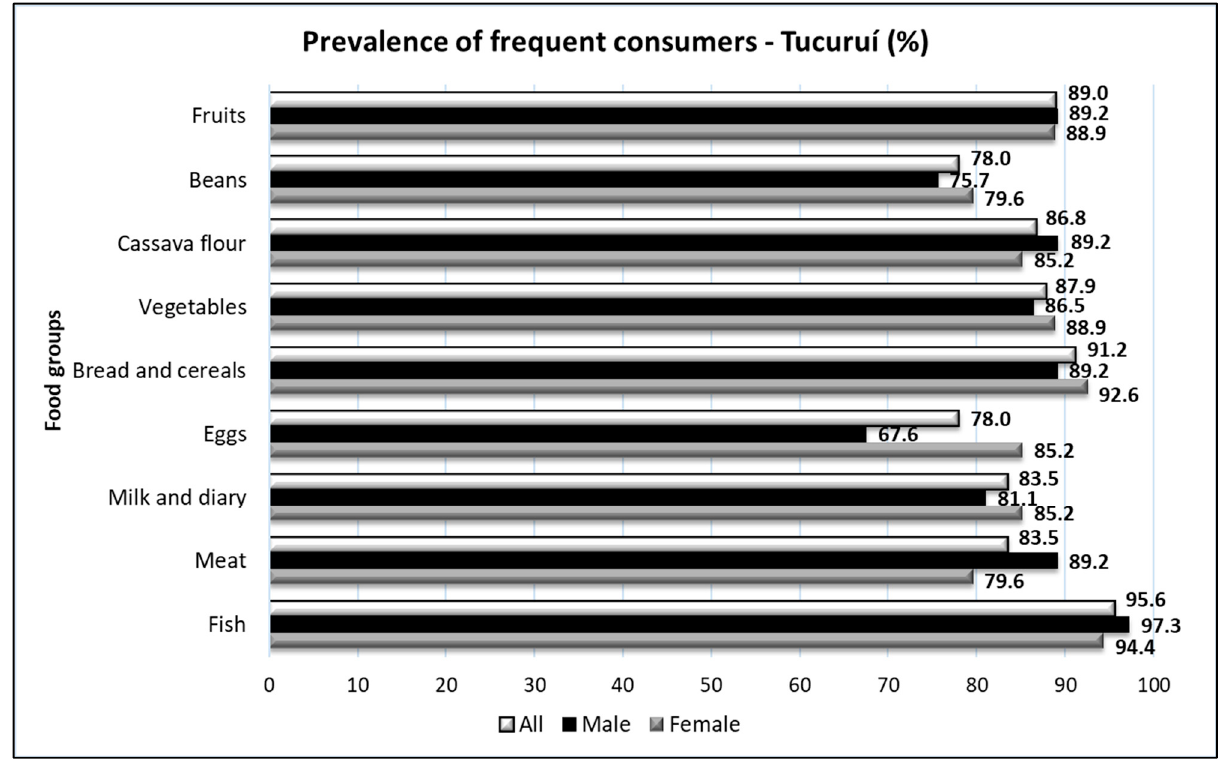
Figure 6. The prevalence of consumers (three or more times a week) of different food groups in all participants from the Tucuruí region (All, n = 91) according to gender, male (n = 37) and female (n = 54).